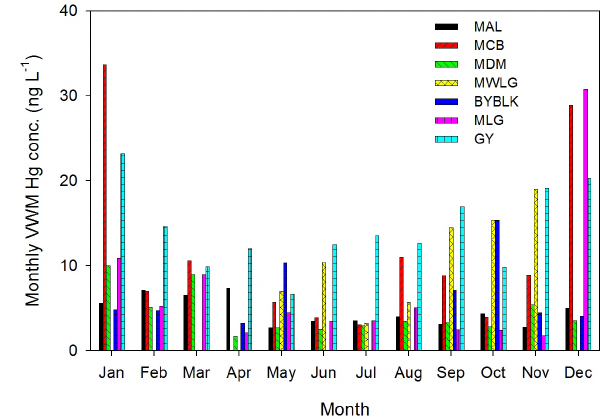
Figure 3. Monthly variations in volume-weighted mean (VWM) Hg concentrations at rural and urban sites in